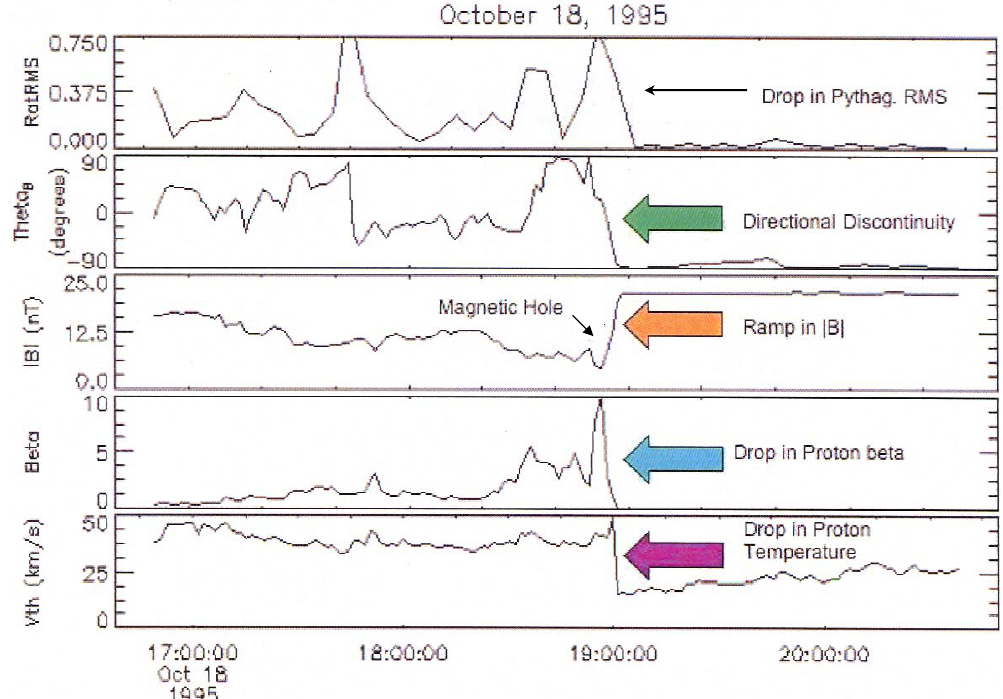
Fig. 1. An example of the profile of a front boundary crossing of a MC, that of 18 October 1995, at approximately hour 19, as seen in WIND field and plasma data. The indicators of the boundary are shown by the color-coded arrows, along with their literal denotations. The quantities plotted are B-RMS (thin black arrow), theta B (heavy green arrow), magnetic field magnitude, | B | (heavy orange), proton plasma beta (heavy light blue), and V Th (heavy purple); a magnetic hole, sometimes occurring at a MC’s front boundary, is indicated by a thin black vertical arrow. Only four of these six quantities (those with heavy colored arrows) will be incorporated into the boundary identification scheme as described in the text, but all six were